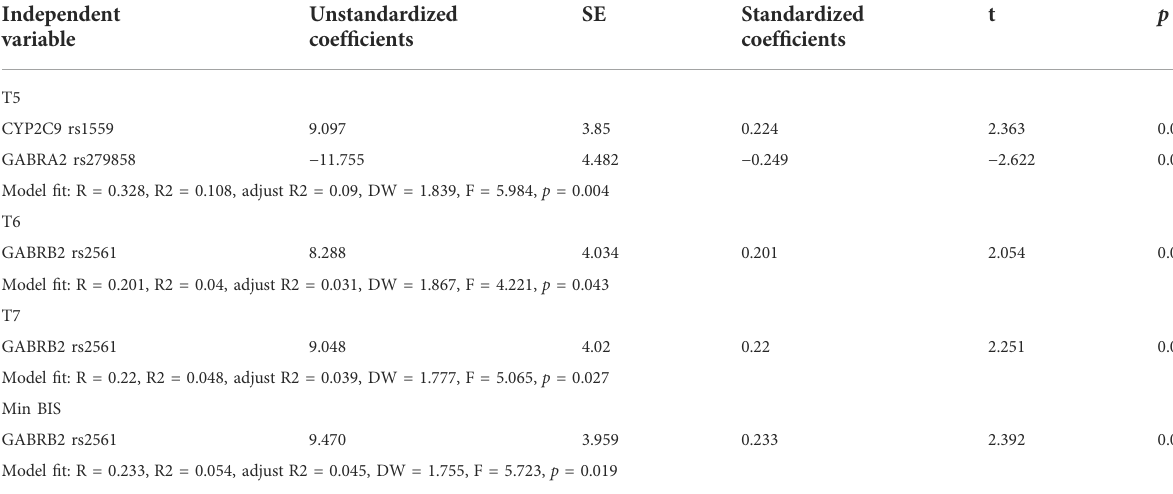
TABLE 3 Multiple linear regression analysis of clinical variables related to BIS. Independent